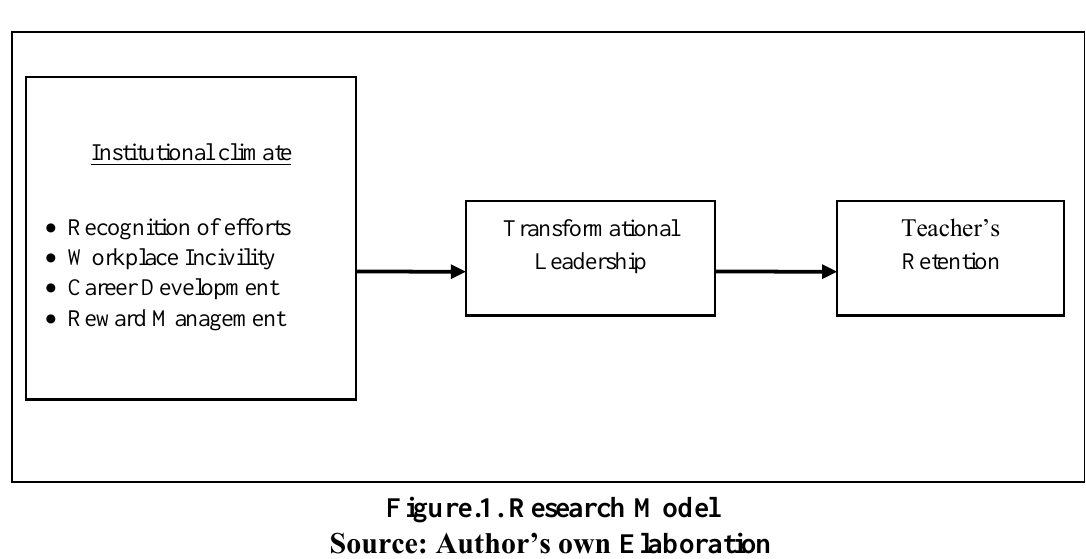
Figure.1. Research